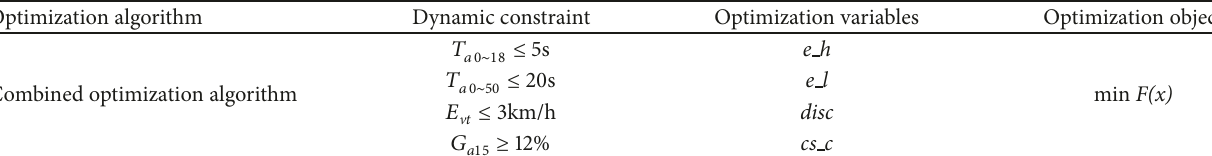
Table 9: Optimization parameters and